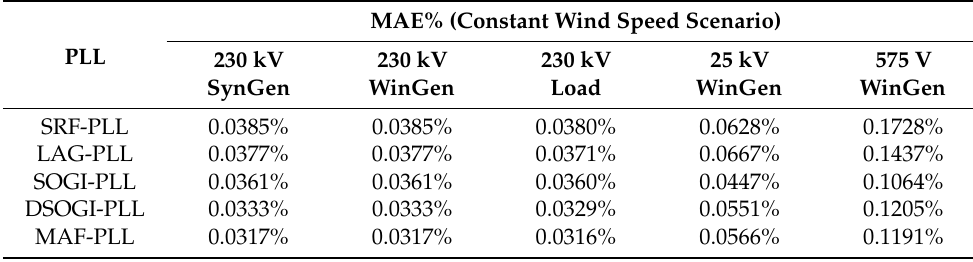
Table 2. Relative mean absolute error for the PLLs located at the different buses in the constant wind speed scenario.